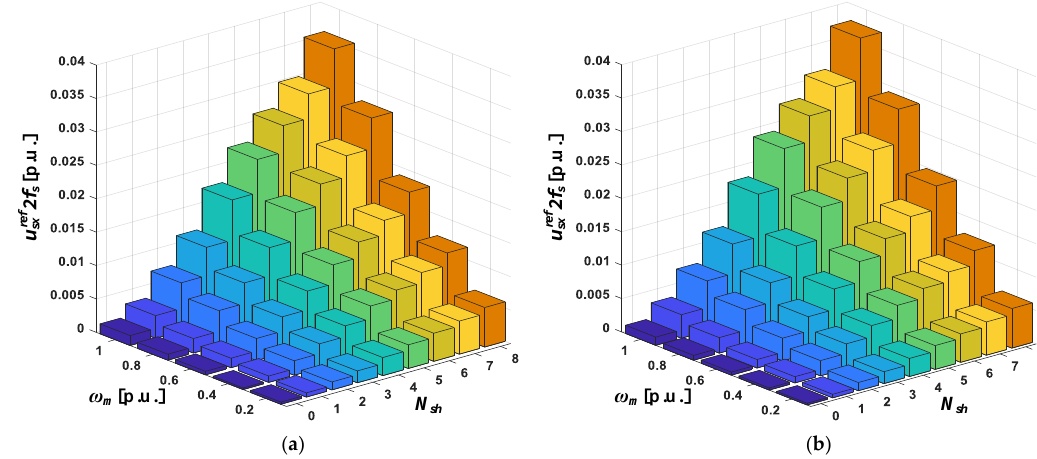
Figure 14. Amplitudes of f sh harmonic of u sx reference voltage component for different numbers of short-circuit turns and different motor speeds with t l = 0.6 t lN in the case of ( a ) speed measurement and ( b ) sensorless operation.